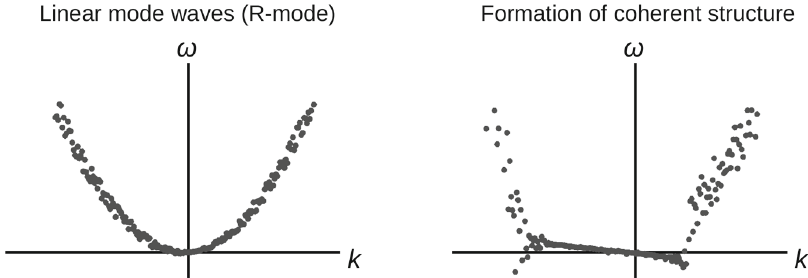
Fig. 8 Transition from linear mode waves into a formation of coherent structure by re-organizing the dispersion relation with a constant group speed over a wide range of wavenumbers. Image adapted from Nariyuki and Hada